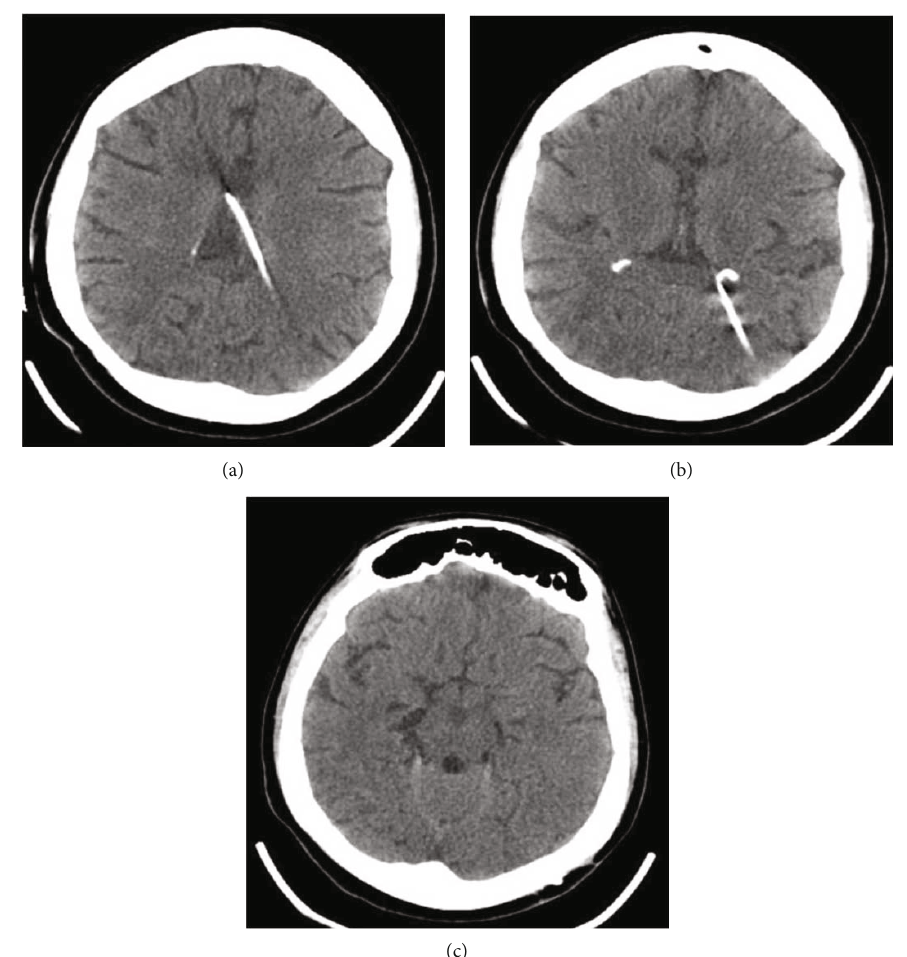
Figure 6: (a – c) Postoperative cranial CT demonstrating the reduction of ventricle sizes. The ventricle catheter is well positioned.